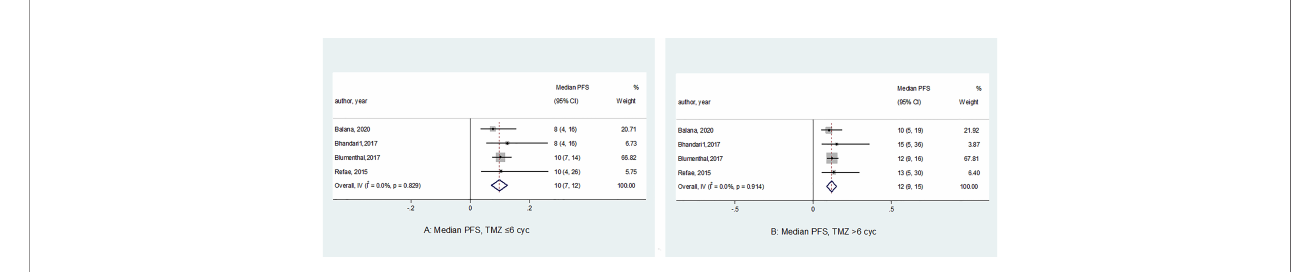
FIGURE 2 | Forest plots of the median progression-free survival (PFS) according to the number of adjuvant temozolomide cycles. The horizontal line of the diamond summary represents the average 95% CI. The statistical heterogeneity between studies was assessed using the I 2 test, which revealed a homogeneity in the results